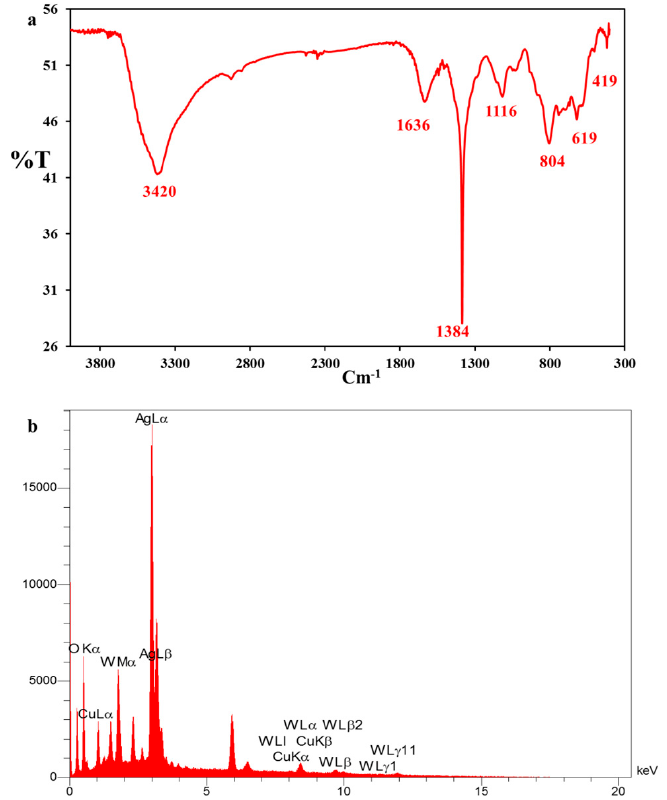
Figure 2. ( a ) FTIR and ( b ) EDX spectra from the spongin-Cu 2 WO 4 (OH) 2 @AgNPs.